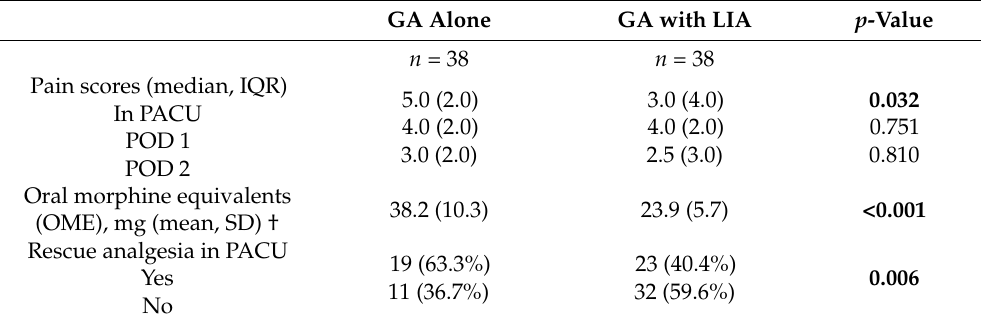
Table 5. Comparison of pain scores and opioid requirements of patients who received a general anesthesia alone versus those who received general anesthesia with local infiltration